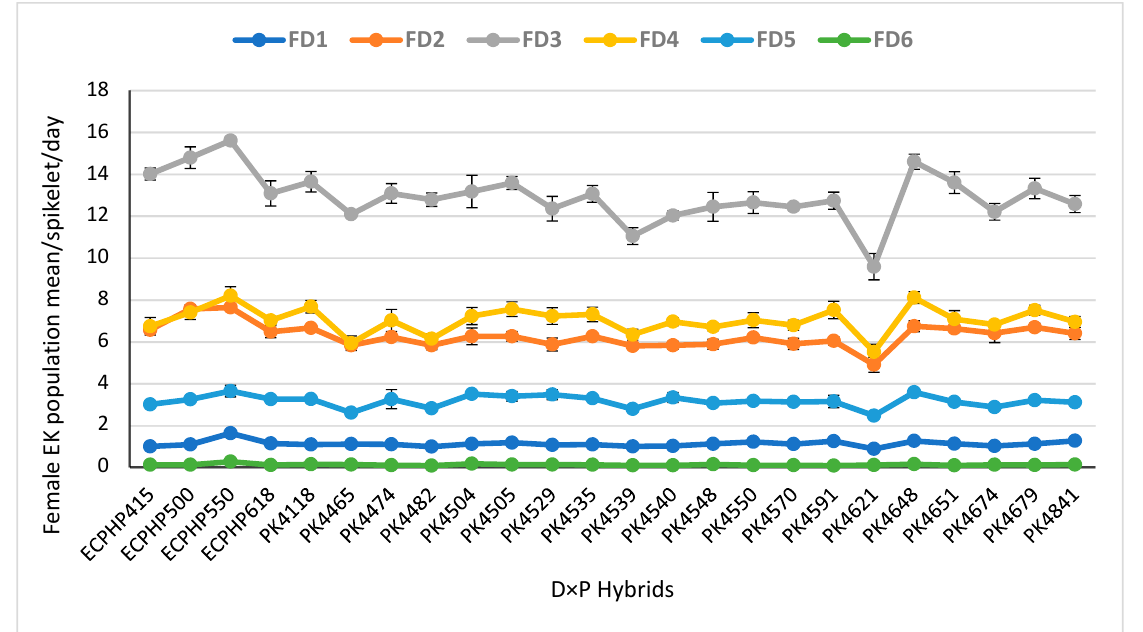
Figure 4. Female Elaeidobius kamerunicus population mean per spikelet on each anthesis phase in biparental hybrids. Mean ± standard errors are presented in the figure as each data point: FD1 (female day-one), FD2 (female day-two), FD3 (female day-three), FD4 (female day-four), FD5 (female day-five), FD6 (female day-six); ECPHP, Elaeis guineensis crossing program Hulu Paka; PK, Porim Kluang; Tukey’s studentized range (HSD) at p ˂ 0.05.